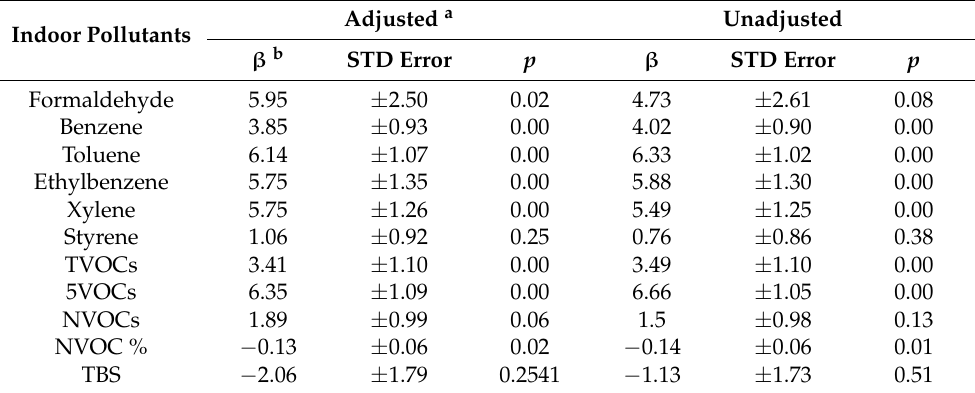
Table 7. Correlation between indoor air pollutants and the SCORAD